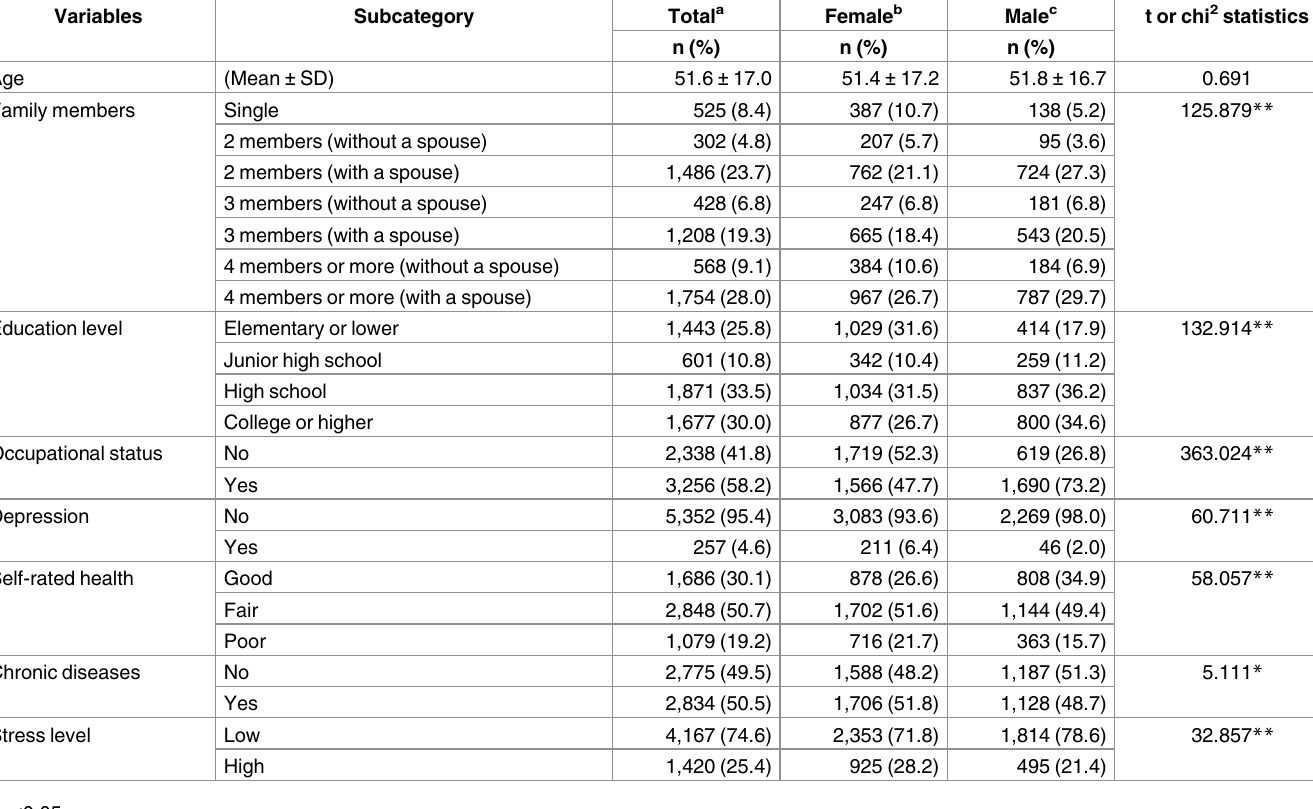
Table 1. Characteristics of the study population and univariable analysis on stress